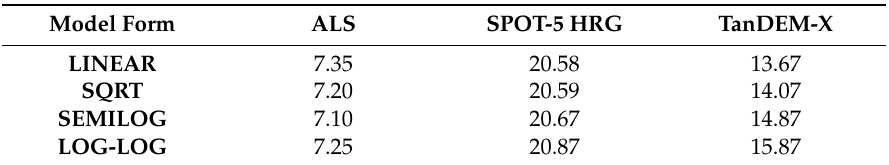
Table B2. Relative RMSE (%) values for the mean height variable of interest. Results for models based on ALS- and SPOT-5-based RS data are given for data collected in 2010 and results for TanDEM-X data are calculated using data from 2011.